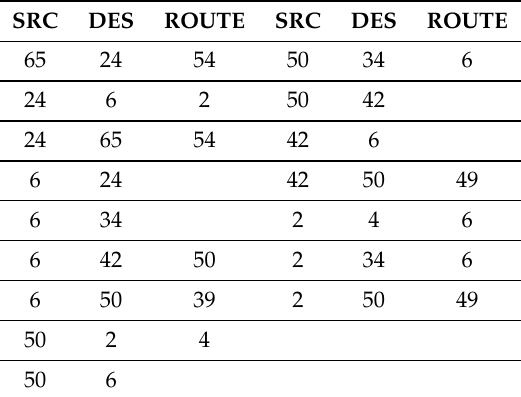
Table 3. Routes of V (cid:42)(cid:41) V .